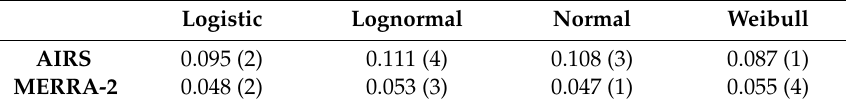
Figure 2. TOC histogram over Egypt for 12 years from AIRS ( upper ) and MERRA-2 ( lower ). Table 2. Goodness of fit for both AIRS and MERRA-2 data over